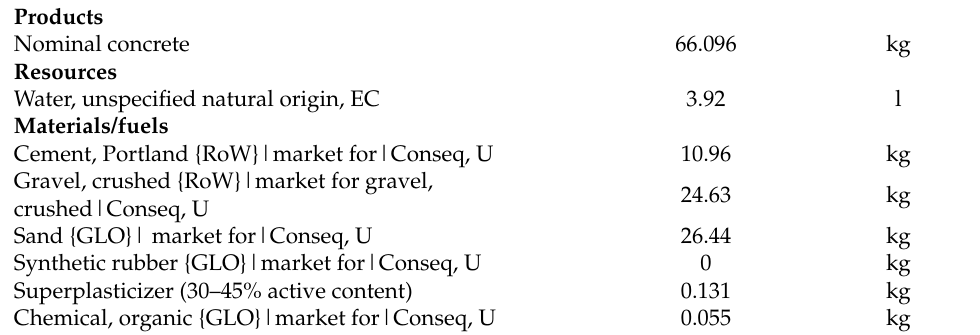
Table 7. Inventory for the nominal concrete.